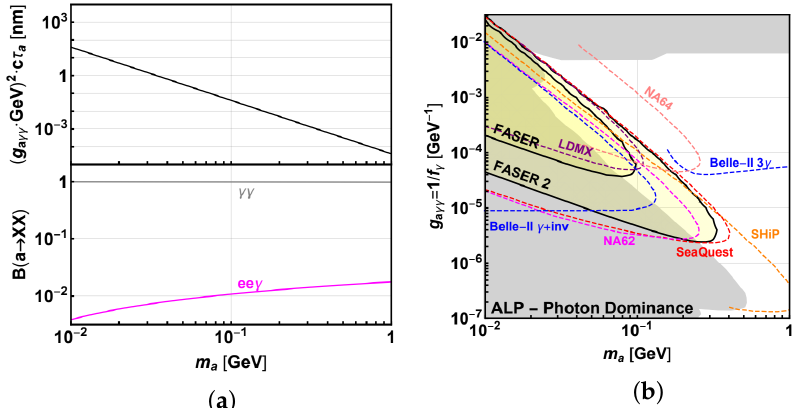
Figure 2. ( a ) ALP decay modes according to mass range. ( b ) FASER and FASER2 accessible parameter space compared with current and proposed experiments